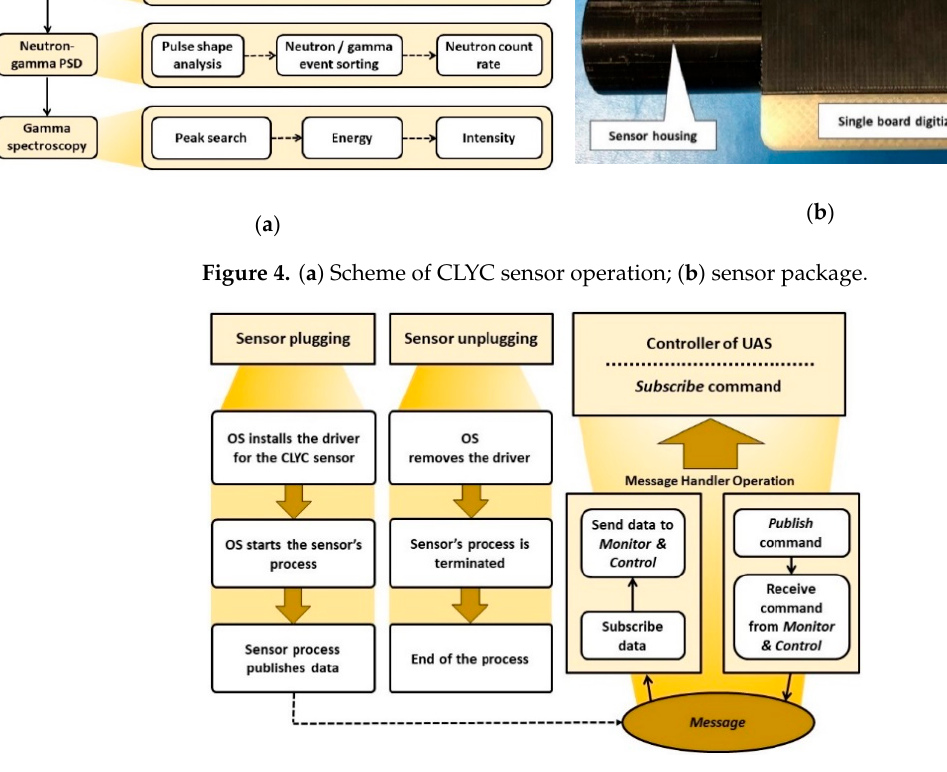
Figure 5. Scheme of “plug and fly” operation of the CLYC sensor. Sensors 2020 , 20 , x FOR PEER REVIEW